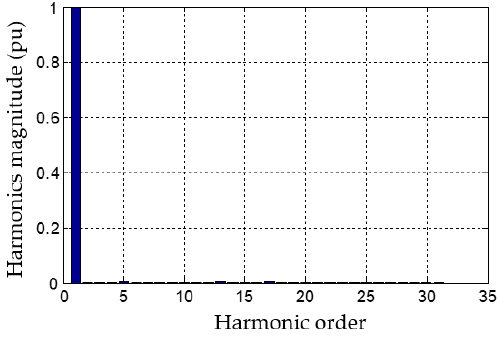
Figure 9. Harmonics spectrum of the supply current after compensation.